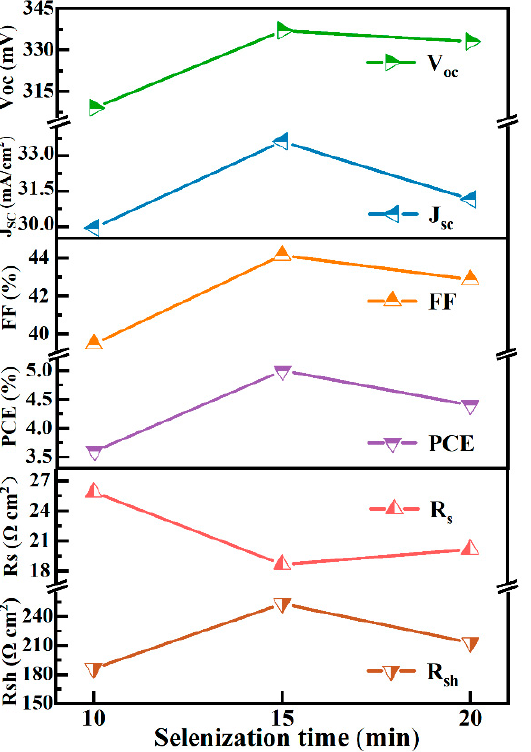
Figure 10. Variation curve of main device parameters as selenidation time.